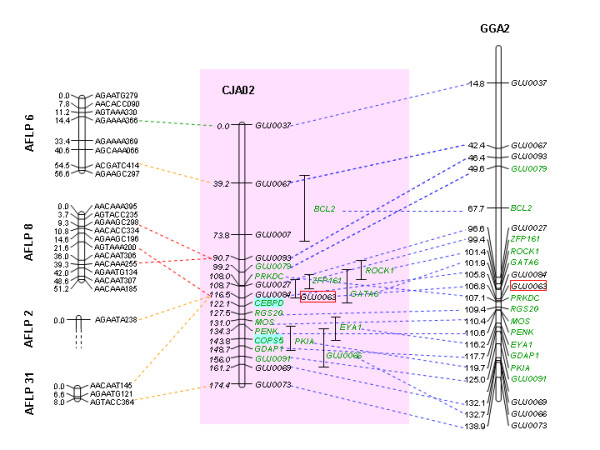
Alignments of Japanese quail microsatellite and AFLP maps and links to the assembled chicken sequence. Left: AFLP linkage groups from [14]; center: integrated microsatellite and gene map (this study); right: chicken February 2004 sequence assembly [22]. AFLP and microsatellite genetic maps are in cM and the sequence assembly is in Mb. New quail linkage groups have blue titles and new microsatellite and gene markers are in green. Genes are in boldface italic. Microsatellite markers informative in both species are in red boxes. Chicken markers have a yellow background. Quail microsatellites or genes with similarity to chicken sequence of unknown location (chrun) have a blue background. Dotted lines linking the microsatellite and the AFLP maps indicate positive results of two-point linkage between the markers, with supporting LOD scores of 3 to 6 (green), 6 to 10 (orange) or more than 10 (red).